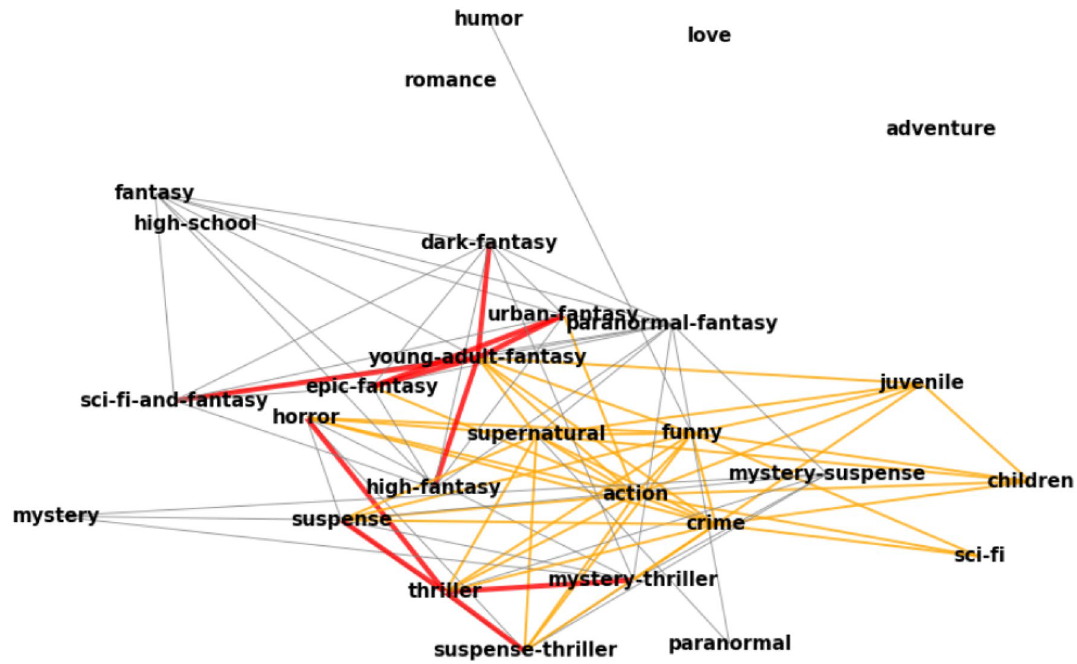
Fig. 6 Topic correlation graph for Goodbooks dataset. Gray lines represent edges with strong word correlations, while orange lines represent strong posterior correlations. Thick red lines represent if both word and posterior correlations are